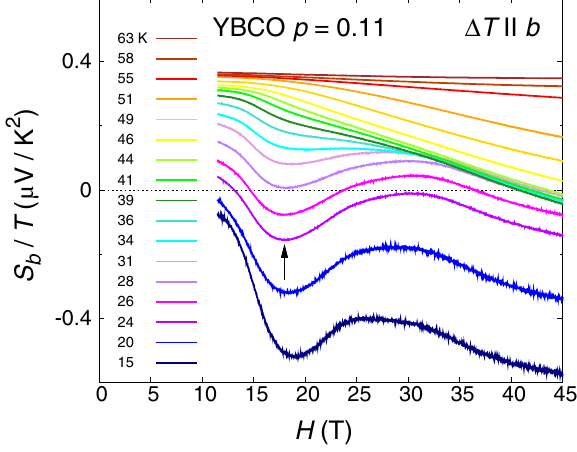
FIG. 3. Seebeck coefficient of YBCO at p ¼ 0 . 11 for a heat current along the b axis, plotted as S=T versus magnetic field H , at various temperatures, as indicated. This more complete data set complements that of Fig. 1(b), showing closely spaced isotherms up to higher field. The arrow marks H , whose value is Seebeck plotted in the H - T phase diagram of Fig. 4. A cut at H ¼ 34 T yields the values of S b =T plotted in Fig. 5(a) (as red 45 T, plotted in Fig. 3. We see that the minimum in S b =T versus H is present at temperatures up to at least 30 K, remaining in roughly the same position. In Fig. 4, we plot H on the H - T phase diagram of YBCO at p ¼ 0 . 11 Seebeck (yellow squares). It is essentially constant in temperature up to 30 K. FIG. 2. Seebeck coefficient of YBCO along the a axis (blue line) and b axis (red line) at T ¼ 20 K, for p ¼ 0 . 11 (a) and p ¼ 0 . 12 (b), plotted as S=T versus magnetic field H . At both dopings, the Seebeck coefficient exhibits a strong anisotropy, manifest as an upturn in S b above H (arrow). Seebeck